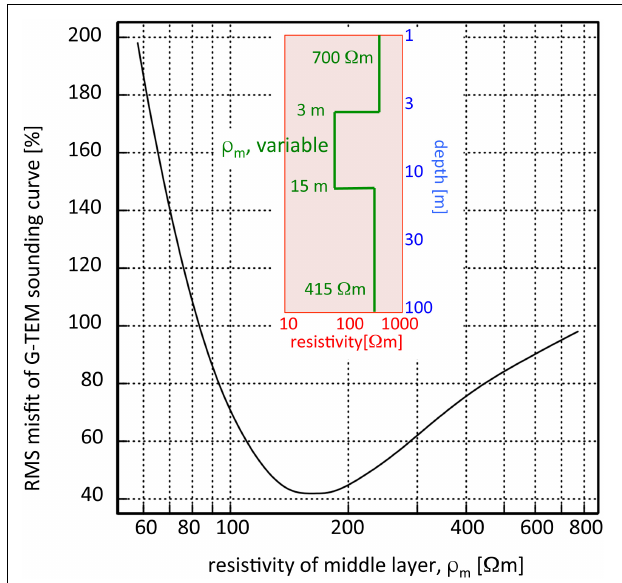
FIGURE 12 | Sensitivity analysis testing the robustness of the conduits observed at the middle sounding station for the G-TEM data shown in Figure 11. The 3-layer model has fixed resistivities of 700 (cid:127) m and 415 (cid:127) m for the upper and lower layers, respectively, whereas the middle layer resistivity is allowed to vary between 60 and 800 (cid:127) m. The resulting curve shows the calculated misfits for the variable resistivities, demonstrating the low resistivity zone (interpreted conduit) having the lowest RMS misfit at ∼ 150 (cid:127) m is a robust feature required by the